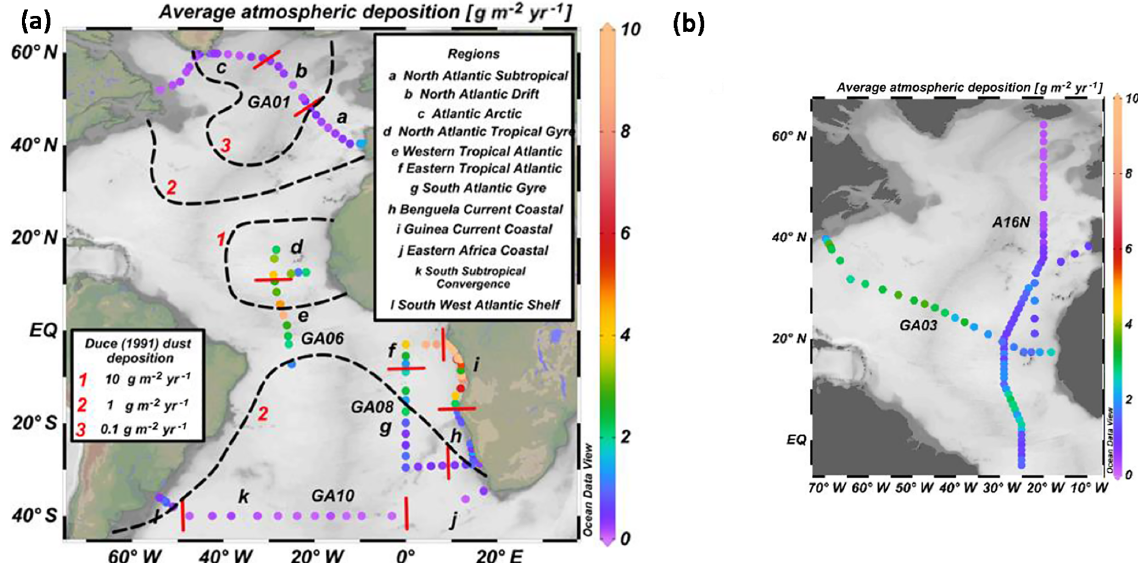
Figure 6. (a) Average atmospheric deposition fluxes determined for the four GEOTRACES cruises. (b) Average atmospheric deposition fluxes determined from GEOTRACES GA03 and A16N-2003 cruises are plotted (Measures et al., 2015). Black dashed lines define bound- aries of atmospheric deposition from Duce et al.